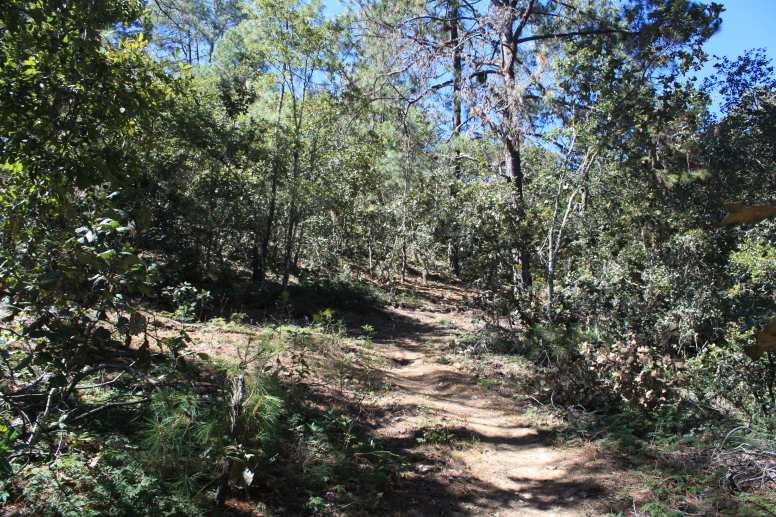
Brachypelma
schroederi habitat, pine-oak forest, near Mitla, Oaxaca State, Mexico. Photo: Stuart J. Longhorn.